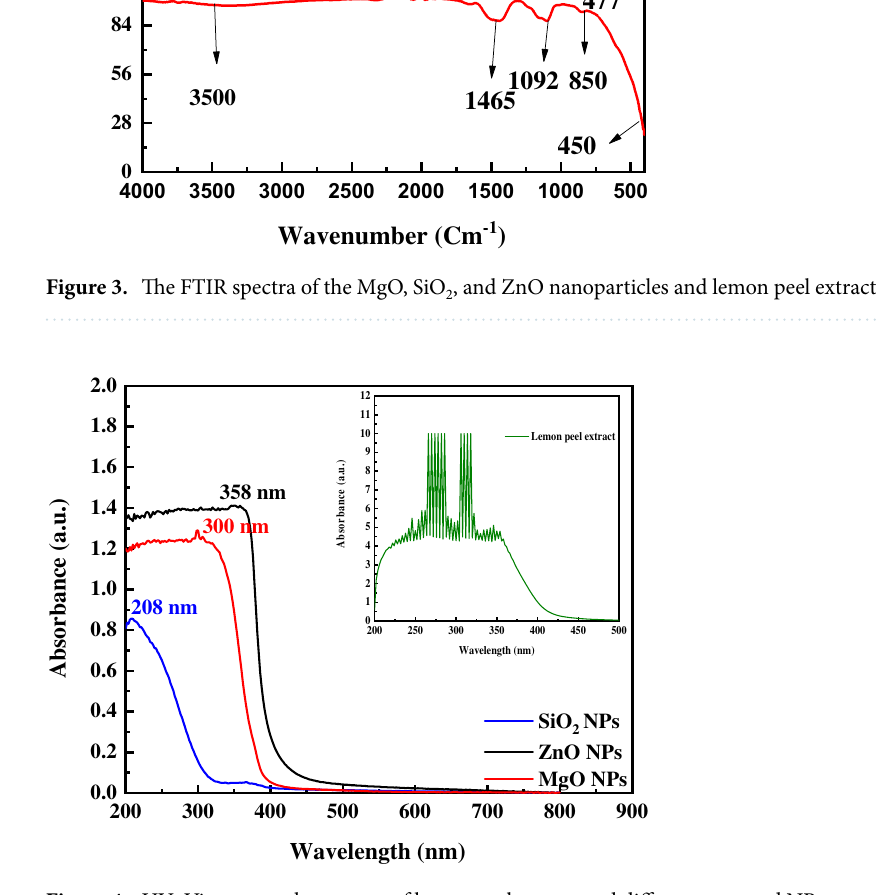
Figure 4. UV–Vis spectrophotometer of lemon peel extract and different prepared